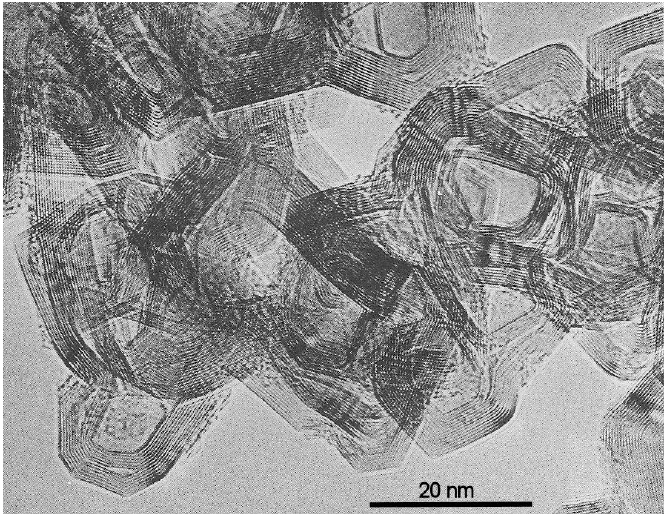
Figure 2. Early lattice image of carbon black, by Ban. Reproduced with permission from [36]. Royal Society of Chemistry, 1972.